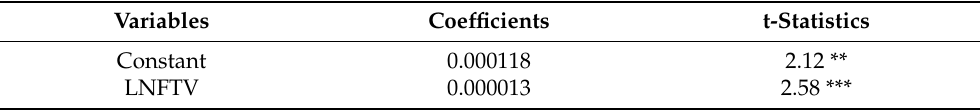
*** and * indicate significance at 1% and 10% levels, respectively. Table 6. The estimated long-run